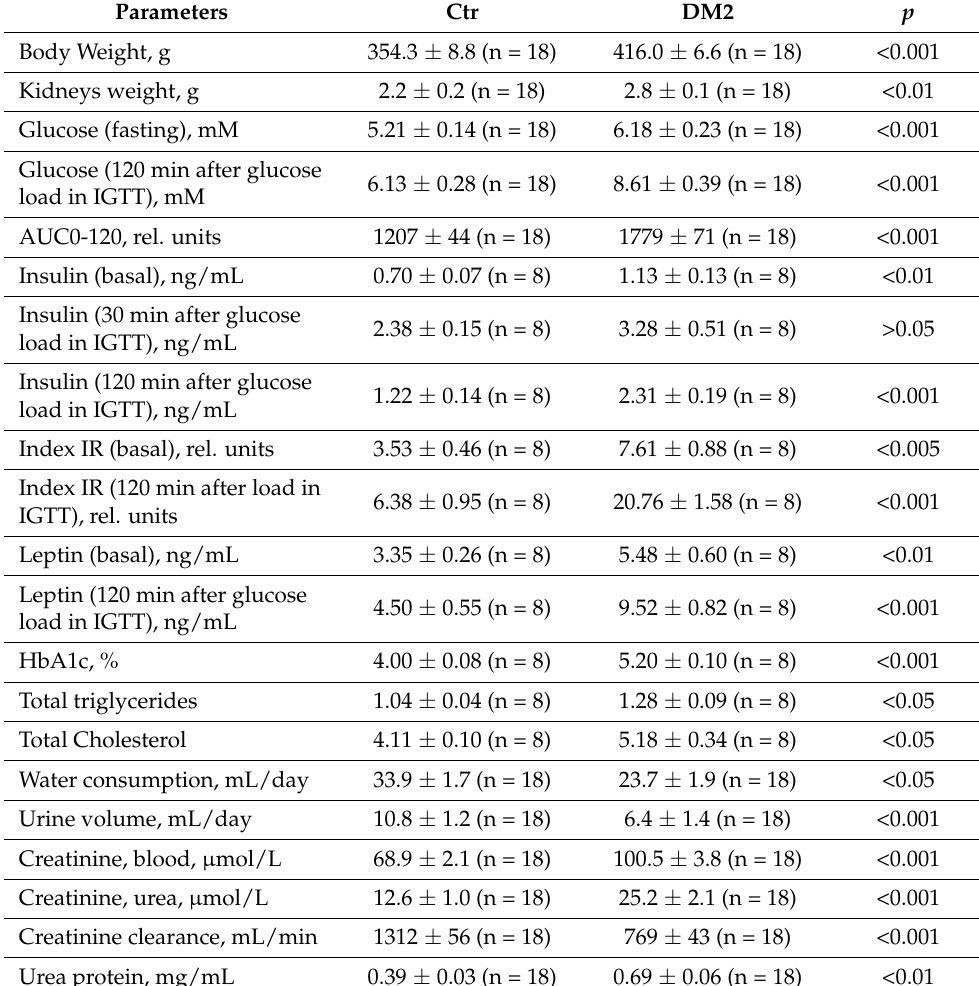
Table 1. Body, fat and kidney weight, daily water consumption, daily volume of urine, creatinine clearance and the biochemical parameters in rats with type 2 diabetes mellitus induced by 16-week high-fat diet and single low-dose STZ, as compared to control animals. The data are presented as the Mean ± SEM. Parameters Ctr DM2 p Body Weight, g 354.3 ± 8.8 (n = 18) 416.0 ± 6.6 (n =